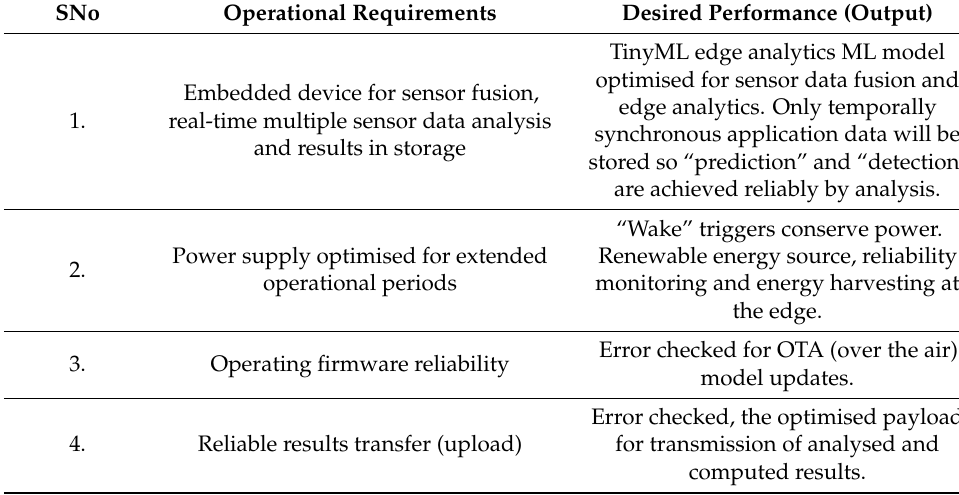
Table 1. The features and performance of a sensor fusion operational environment.